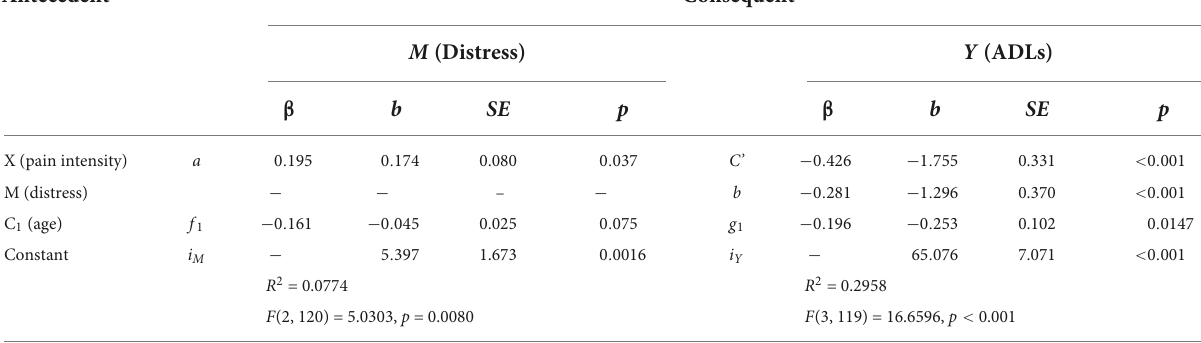
TABLE 5 Model coefficients for the pain intensity, distress, ADLs simple mediation model with covariate of age.